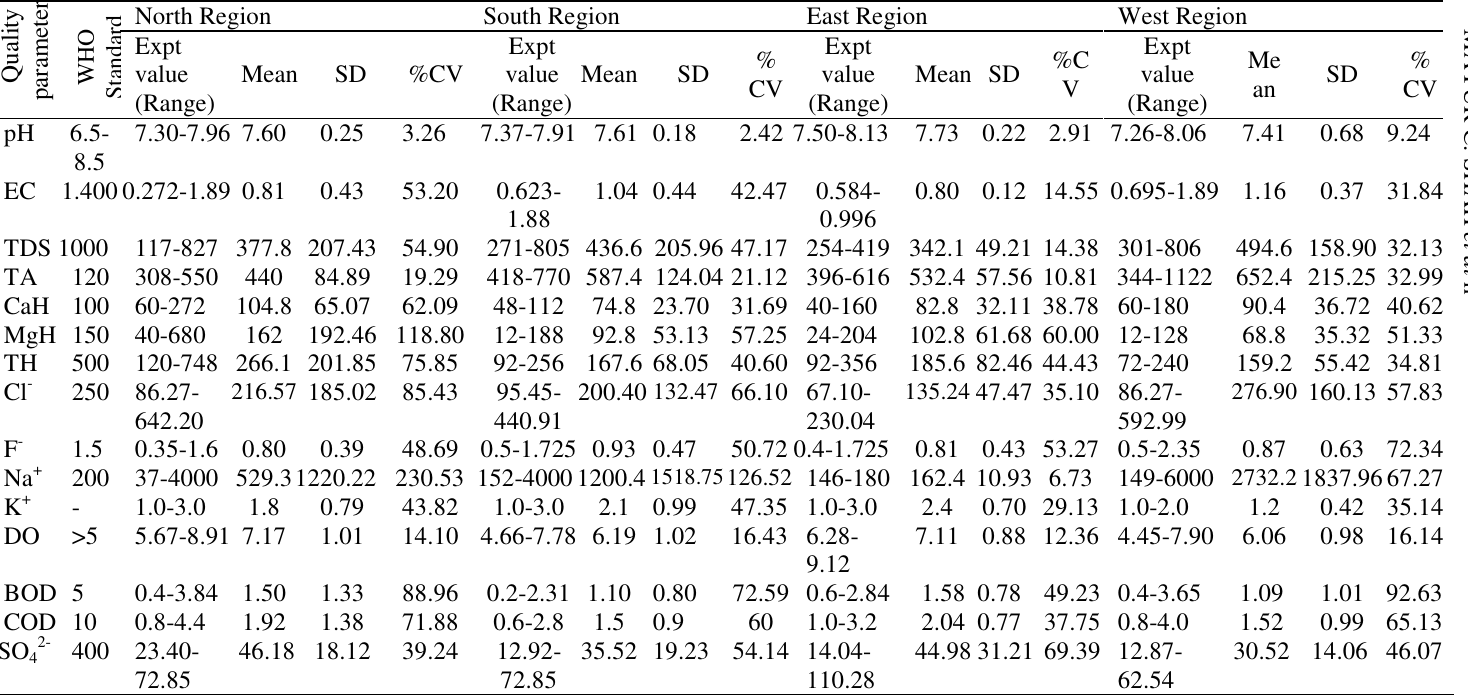
Values of all parameters are in mg/L except pH and EC (mS/cm